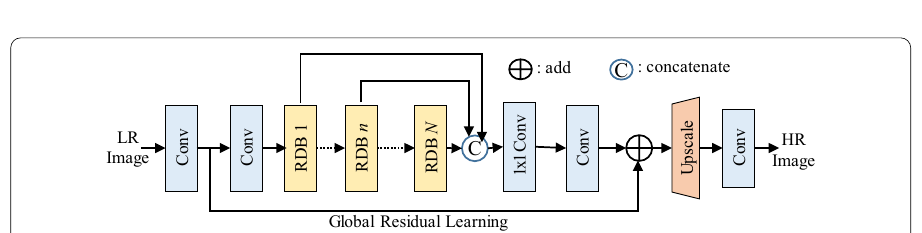
Fig. 4 The architecture of residual dense network